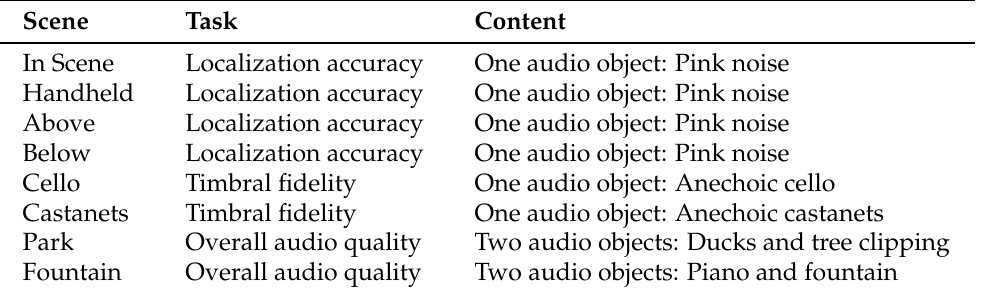
Table 2. Scenes, task in the scene, and audio content.